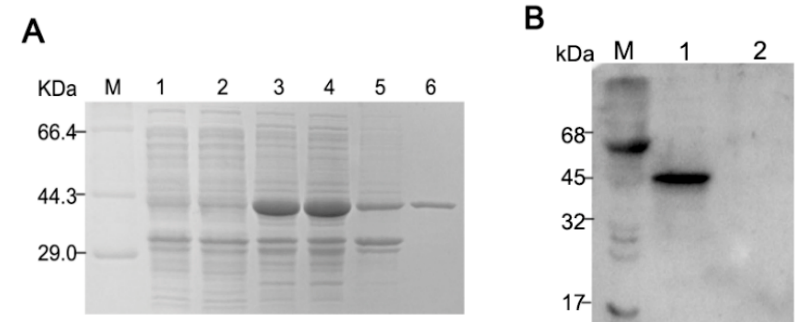
Figure 1. Expression and purification of His-tagged Porcine deltacoronavirus (PDCoV) N-protein. ( A ) SDS-PAGE of pET28a-N transfected BL21 (DE3) cells. M, protein molecular weight marker; lane 1: E. coli BL21 with empty vector pET-28a ( + ); lane 2: Uninduced E.coli BL21 with pET-28a-N; lane 3, IPTG-induced pET28a-N transfected cells prior to sonication, lane 4, supernatant of pET28a-N transfected cells post sonication; lane 5: the precipitates of bacterium solution; lane 6: Ni-NTA purified rNP from supernatant; ( B ) Western blot of E. coli expressed pET28a-N (lane 1) and empty vector pET-28a (lane 2), probed with hyperimmune pig anti-PDCoV.